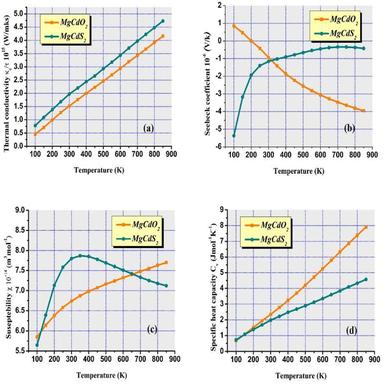
Calculated temperature-dependent (a) Thermal conductivity (b) Seebeck coefficient, (c) Susceptibility, and (d) Specific heat capacity for MgCdX2 (X ¼ O, S), respectively.